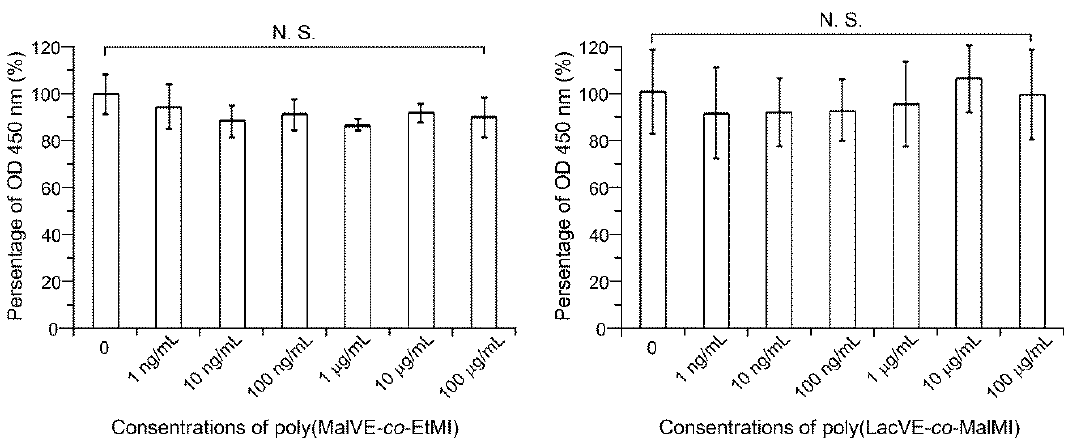
Figure S1: 1 H and 13 C NMR spectra of vinyl monomers (MalVE, LacVE and MalMI), Figure S2: SEC curves of poly(MalVE- co -EtMI) obtained in the radical copolymerization with and without RAFT agent, Scheme S1: Schematics of radical copolymerization of MalVE (M 1 ) and EtMI (M 2 ), Figure S3: time–conversion curves for the RAFT copolymerization of LacVE and EtMI with BTSE, Figure S4: experimentally observed M n and M w / M n value of poly(LacVE- co -EtMI) plotted against theoretical M n of poly(LacVE- co -EtMI), Figure S5: time–conversion curves for the RAFT copolymerization of LacVE and MalMI with BTSE, Figure S6: SEC curves of poly(LacVE- co -MalMI), Figure S7: Photography of poly(MalVE- co -EtMI) and poly(LacVE- co -EtMI) solution before and after the addition of FITC-unlabeled Con A or PNA.